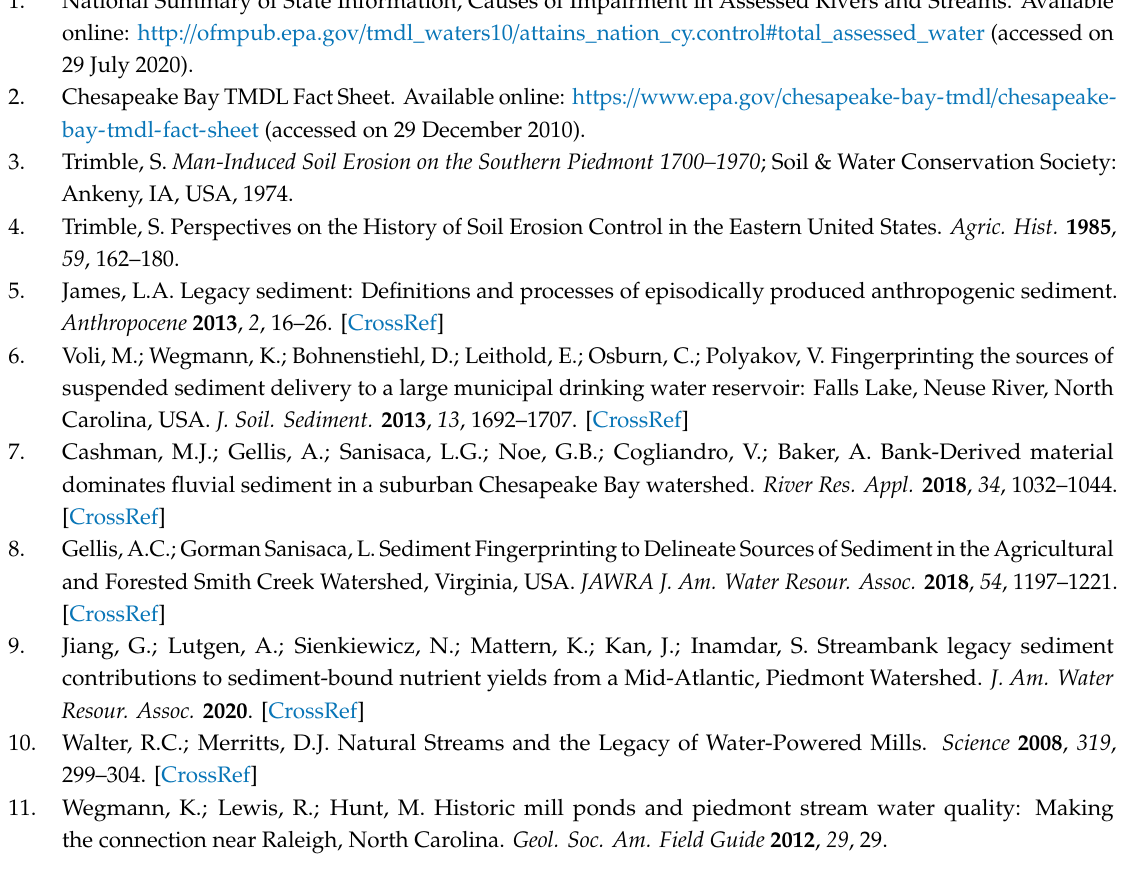
Figure S1: 1858 Martenet map showing historic mill dams (circled in yellow) along Gramies Run (previously known as Fulling Mill Run), Figure S2: Partial construction along Phase 2 showing restored (left) and unrestored (right) reaches. The junction represents a construction pause for the no-instream work period—1 March to 15 June. Note the buried organic horizon the right and the corresponding level of the newly created floodplain on the left, Figure S3: Streambank at Gramies Run (along Phase II restoration) showing freeze-thaw drool and subaerial erosion, Figure S4: SSC-Turbidity relationship to convert turbidity values to SSC